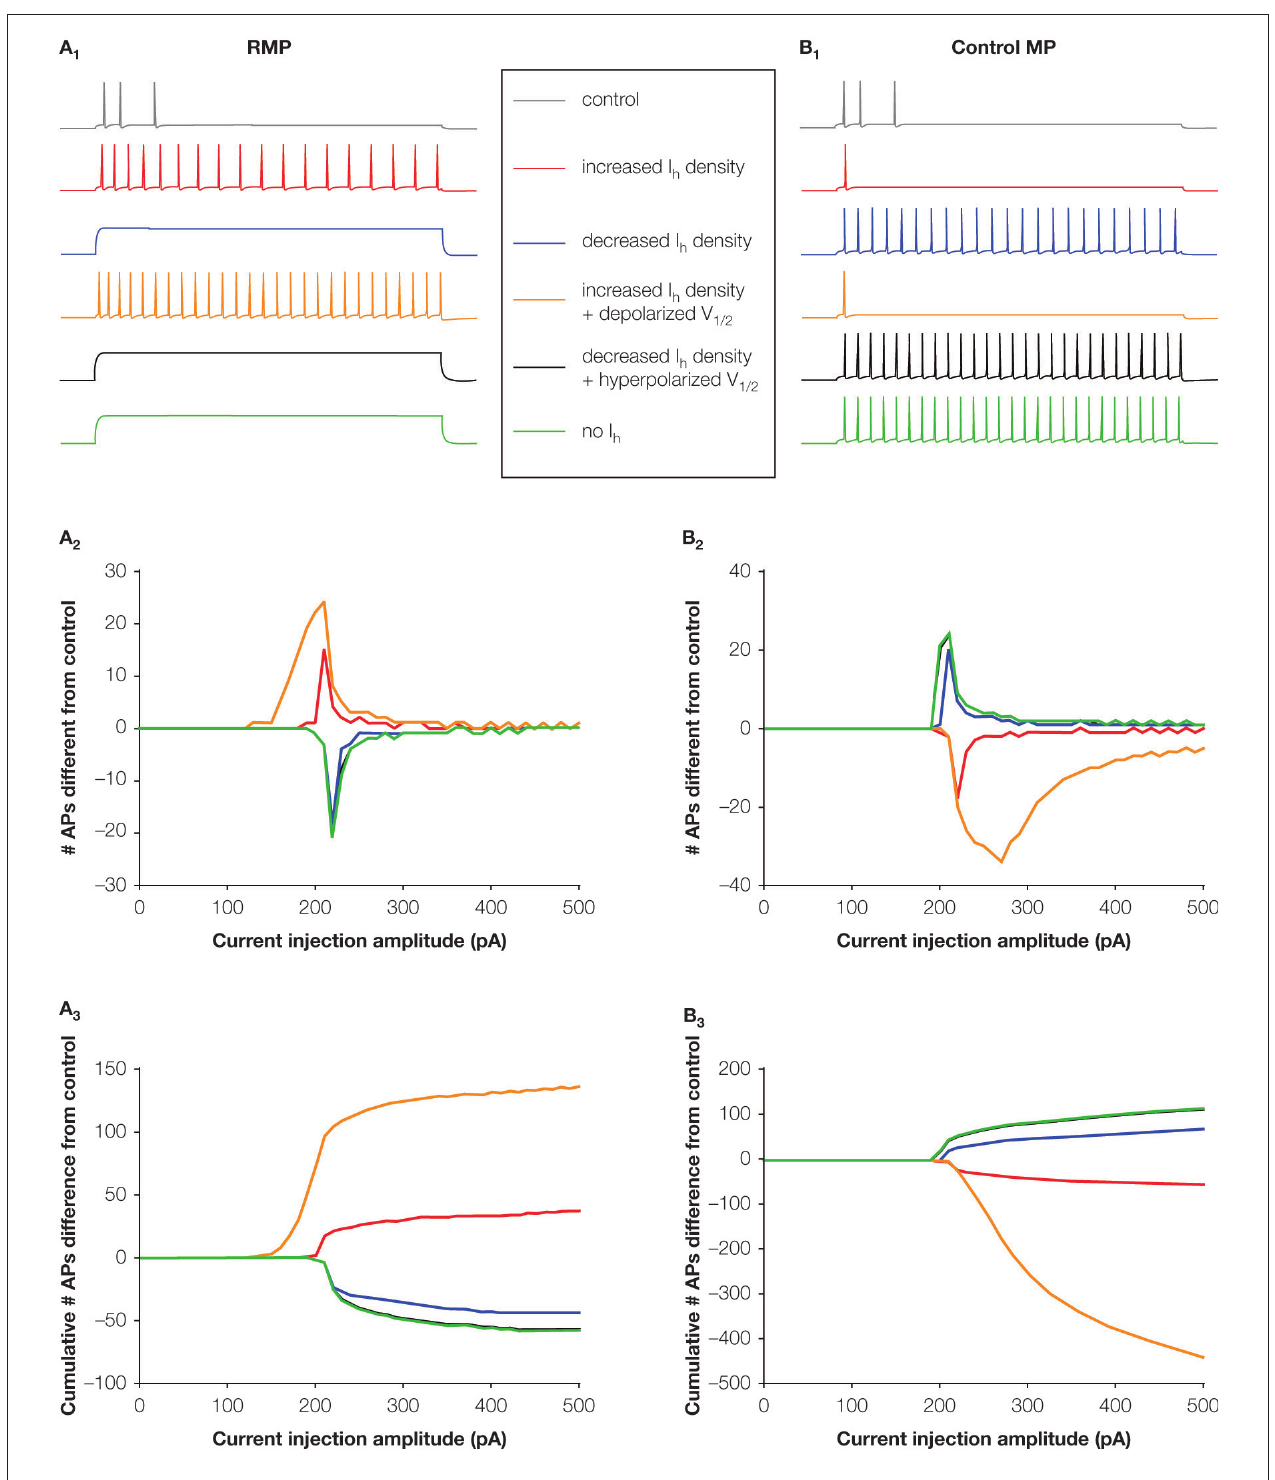
The number of APs fired in models with altered I model for each current injection amplitude. Positive numbers indicate hyper excitability, while negative numbers indicate hypo excitability. (A3, B3) to a 1000 ms h The cumulative number of APs fired in models with altered I from the control model illustrates the impact of different combinations of h-current